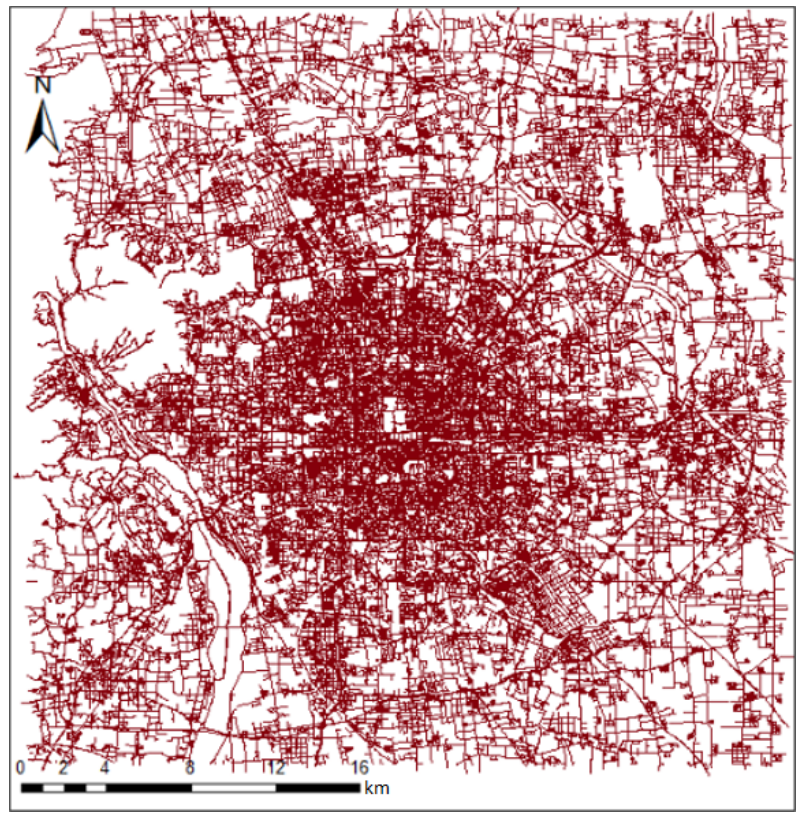
Figure 5. Beijing road